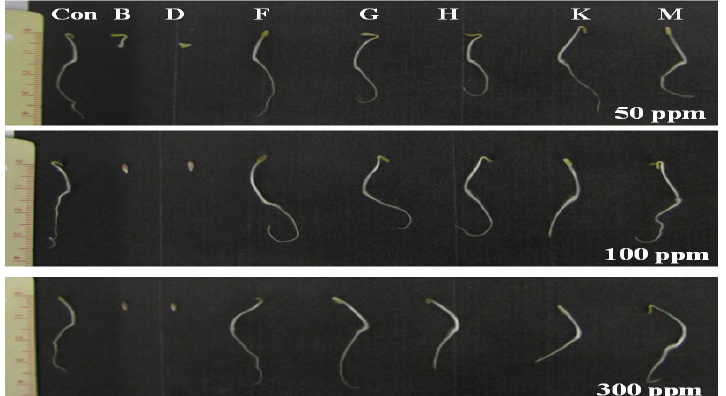
Figure 4. The effect of fractions B, D, F, G, H, K and M on lettuce seed germination and growth is compared more clearly at different concentrations. These fractions were obtained during column chromatography from ethyl acetate extract of Cladosporium cladosporioides LWL5 culture